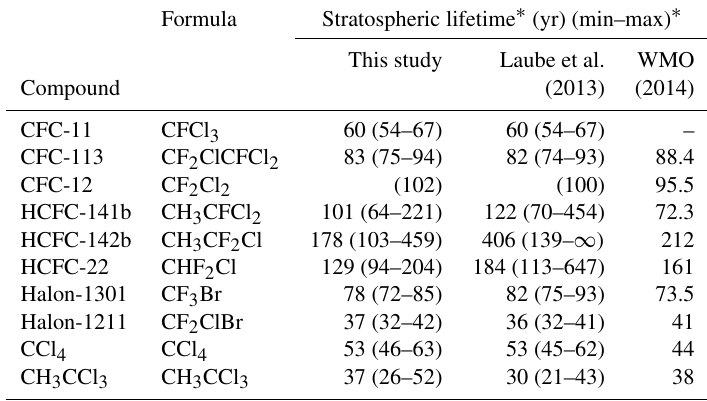
Table 5. Updated stratospheric lifetimes based on “best-estimate” mean ages derived in this study compared to existing literature values. Formula Stratospheric lifetime ∗ (yr) (min–max) ∗ This study